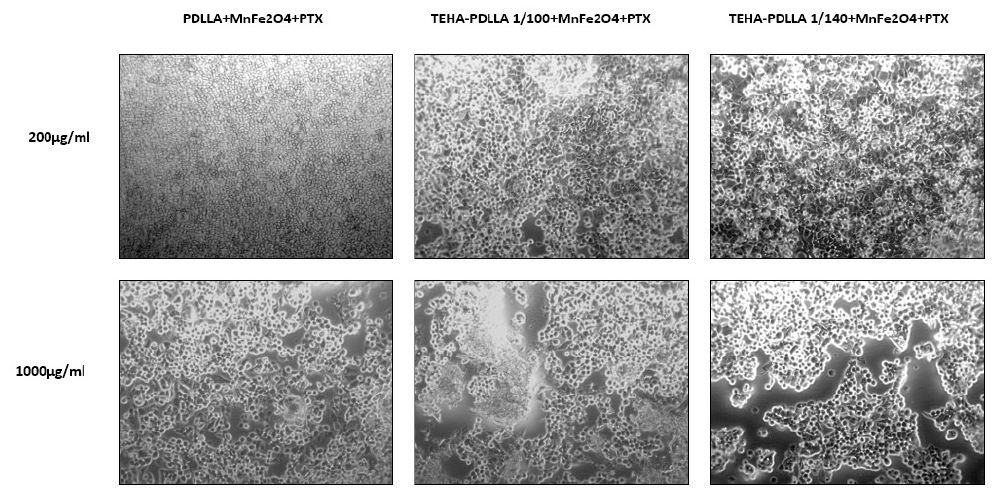
Figure 11. The viability of Caco-2 cells ( A ) and hASCs ( B ) incubated with MNPs. Cells viability was determined by MTT assay cells’ treatment with MNPs (200 and 1000 μg/mL) for 24 h. The absorbance values are directly proportional to metabolic activity of the cells.